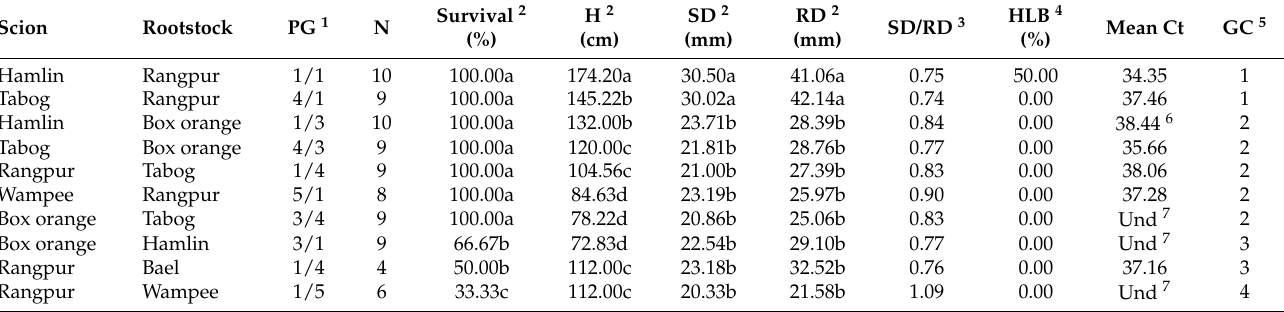
Table 4. Plant survival percentage of scion/rootstock combinations within different Aurantioideae phylogenetic groups (PGs), and mean values of plant height (H), scion stem diameter (SD), rootstock stem diameter (RD), scion and rootstock stem diameter relation (SD/RD), Huanglongbing (HLB) incidence, and ‘ Candidatus Liberibacter asiaticus’ Ct values (Ct) at 12 months after transplanting to the field, and graft compatibility group